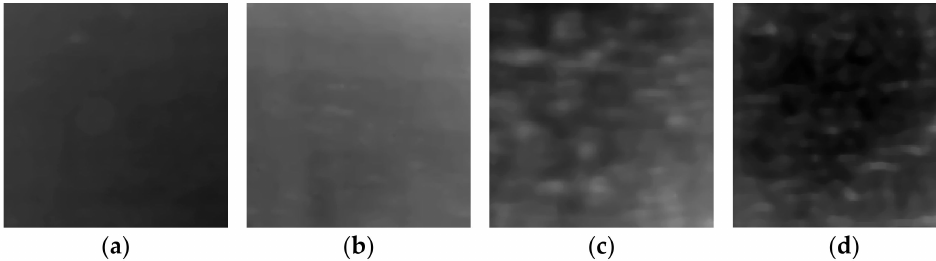
Figure 11. The reconstructed images by the RBF ANN. ( a ) Smooth fluctuation. ( b ) Weak fluctuation. ( c ) Moderate fluctuation. ( d ) Strong fluctuation.